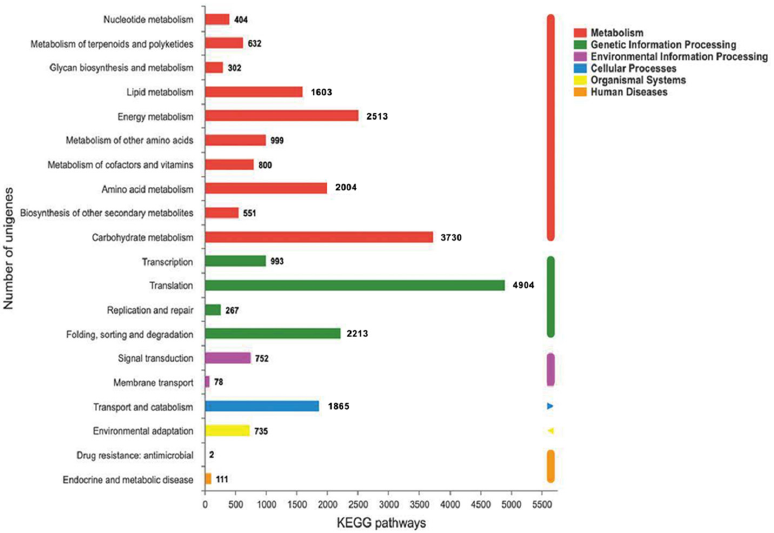
Figure 6. KEGG classification and pathway assignment of unigenes.